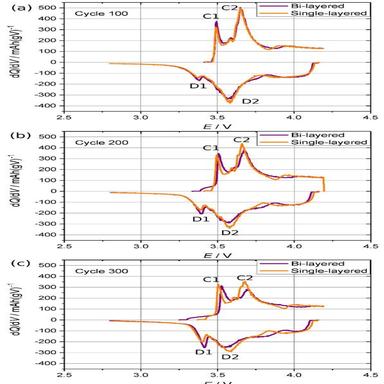
DVA of the Li-ion cells based on the single- (orange) and bi-layered (purple) negative electrodes after (a) 100, (b) 200 and (c) 300 cycles.